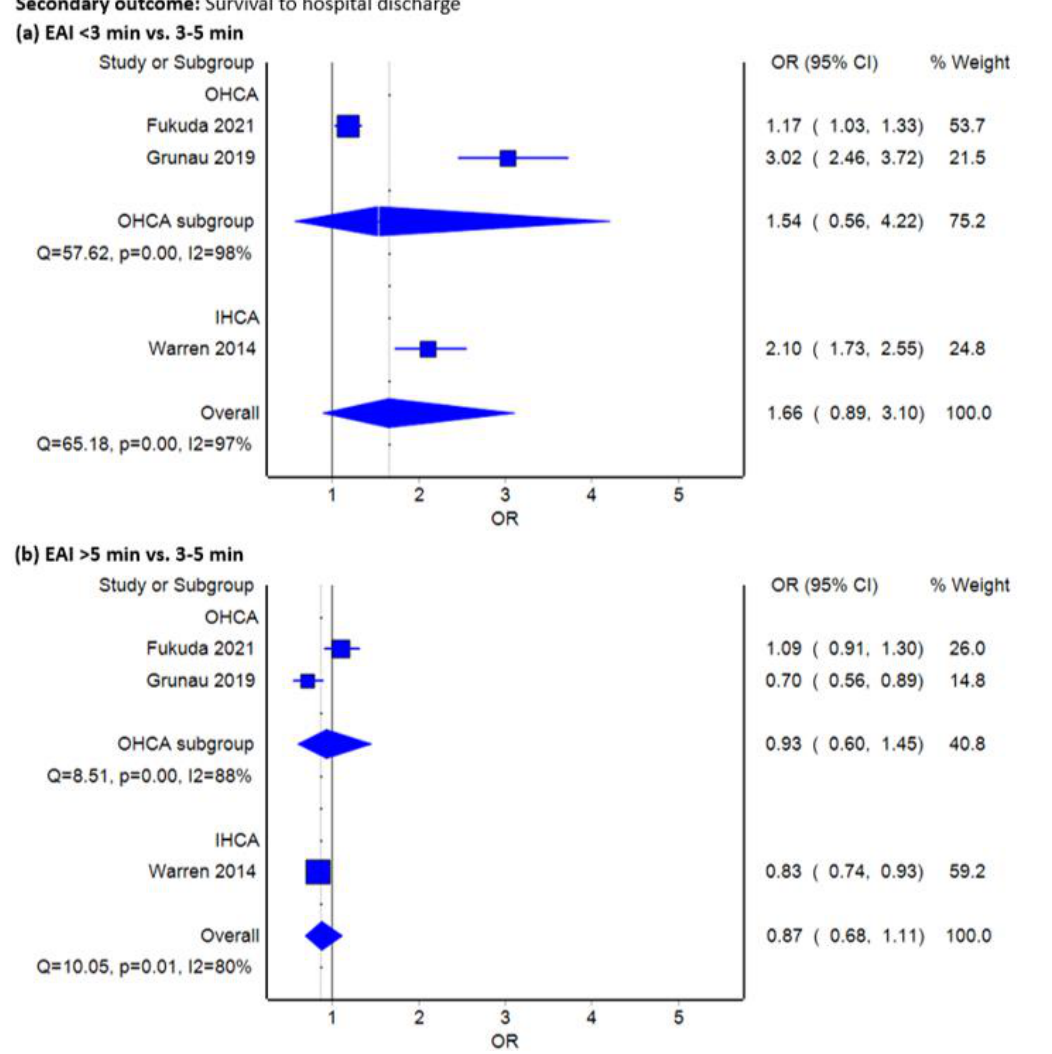
Figure 3. Forest plots comparing survival to hospital discharge between standard epinephrine administration interval (every 3 – 5 min) and ( a ) <3 min or ( b ) >5 min using inverse variance heterogeneity model.